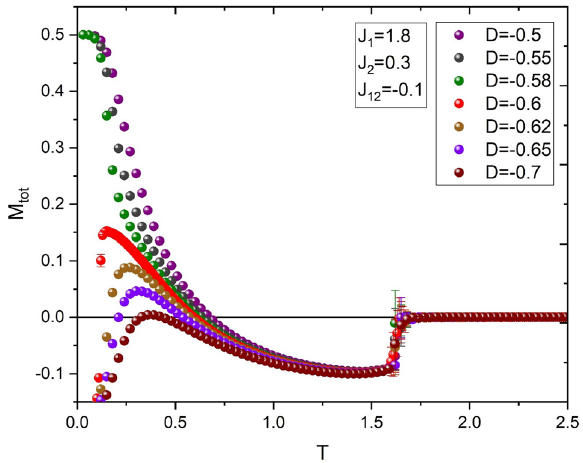
Fig. 7 Binder cumulant as a function of T for different crystal sizes L. The values J 1 , J 2 and J 12 are the same as in Fig.